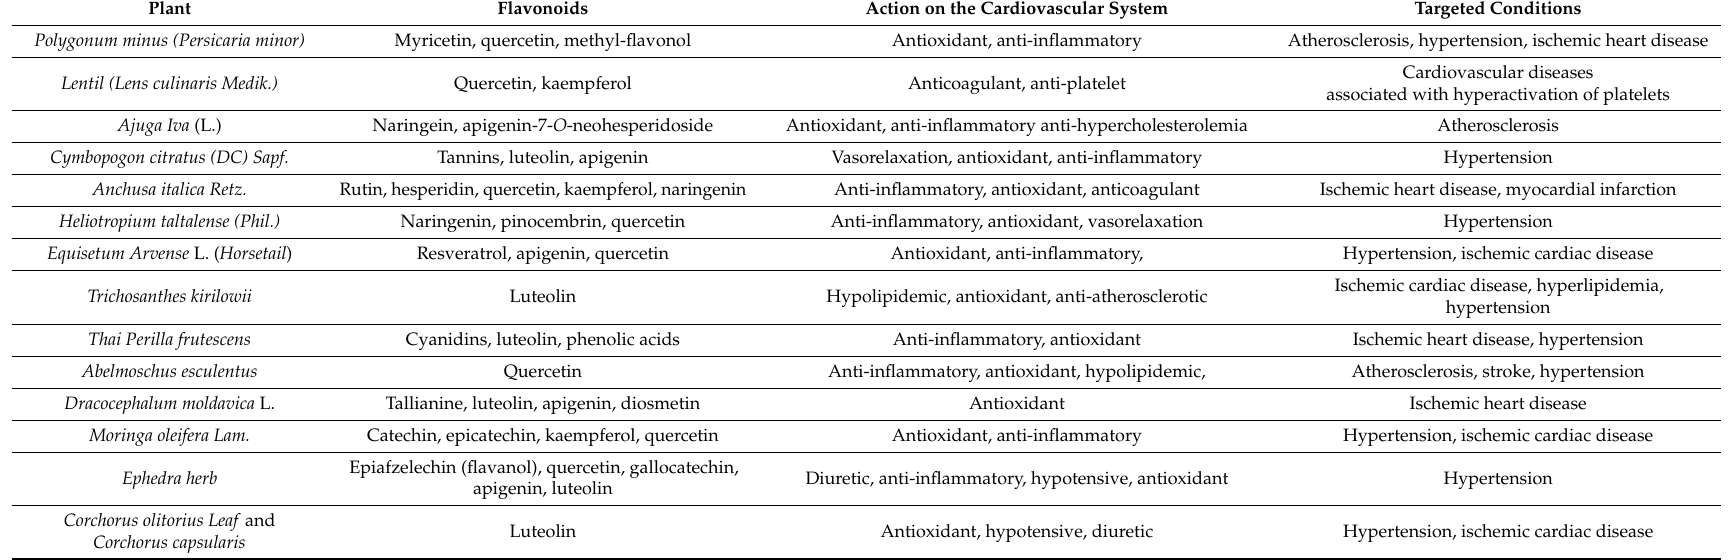
Table 1. Selection of recently published papers discussing the relationship flavonoids–cardiovascular disease.